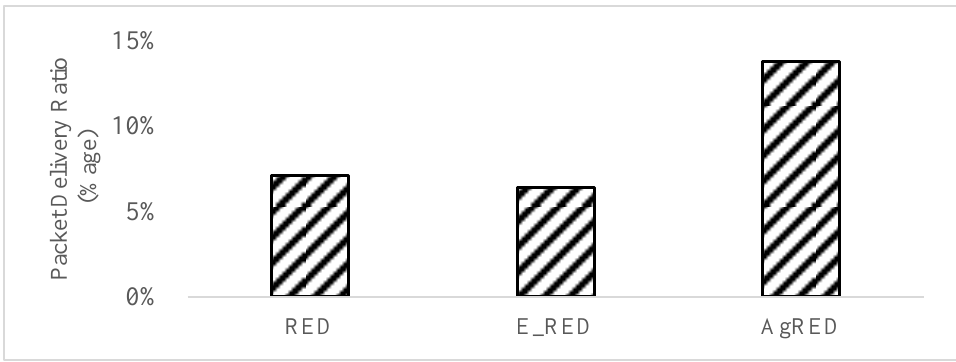
Figure 6. Average packet delivery ratio using UDP for RED, E_RED, and AgRED.